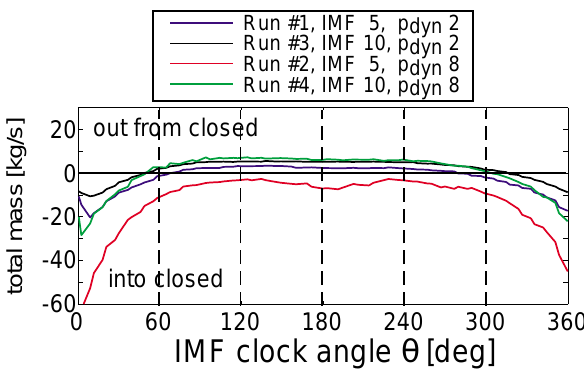
Fig. 7. Net transferred mass to dayside closed field as a function of IMF clock angle (and time) for all